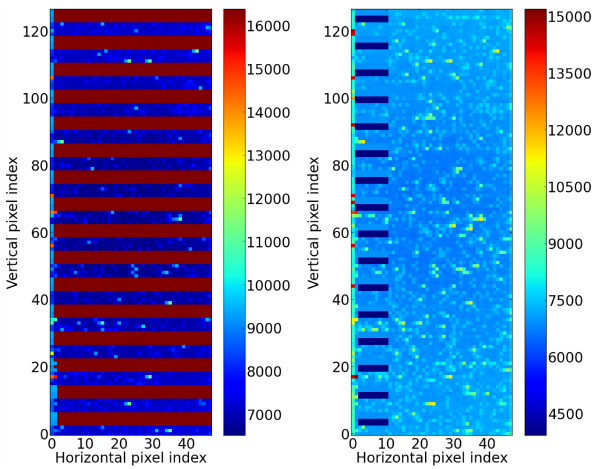
Figure 9. Two examples of raw data frames affected by spikes. The colour code shows the intensity in ADC counts. For details, see text.